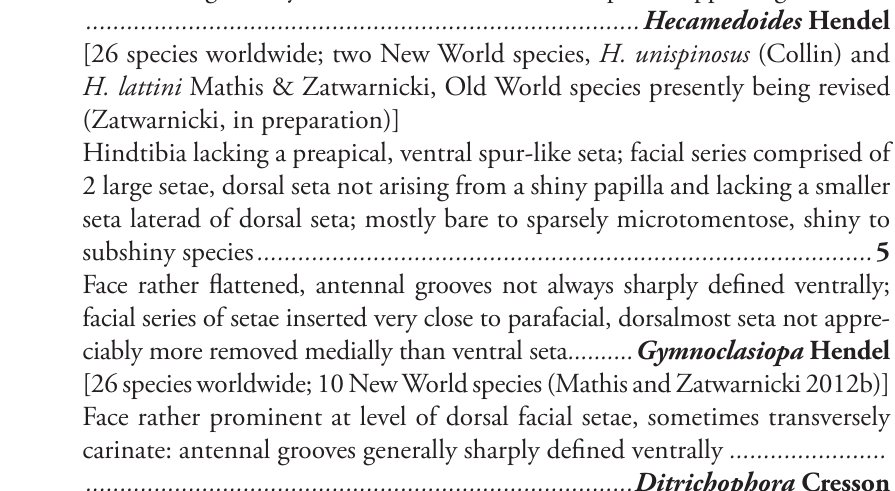
Postsutural supra-alar seta very short or absent, if distinguishable distinctly shorter than posterior notopleural seta. Face without dorsoclinate seta at low- Hindtibia with a preapical, ventral, spur-like seta; facial series comprising 2–3 large setae, dorsal seta inserted slightly medially from other setae and arising from distinct, shiny papilla, with a small, slightly dorsoclinate seta laterad of dorsal seta; generally microtomentose, cinereous species, appearing dull ....... ................................................................................. Hecamedoides Hendel [26 species worldwide; two New World species, H. unispinosus (Collin) and